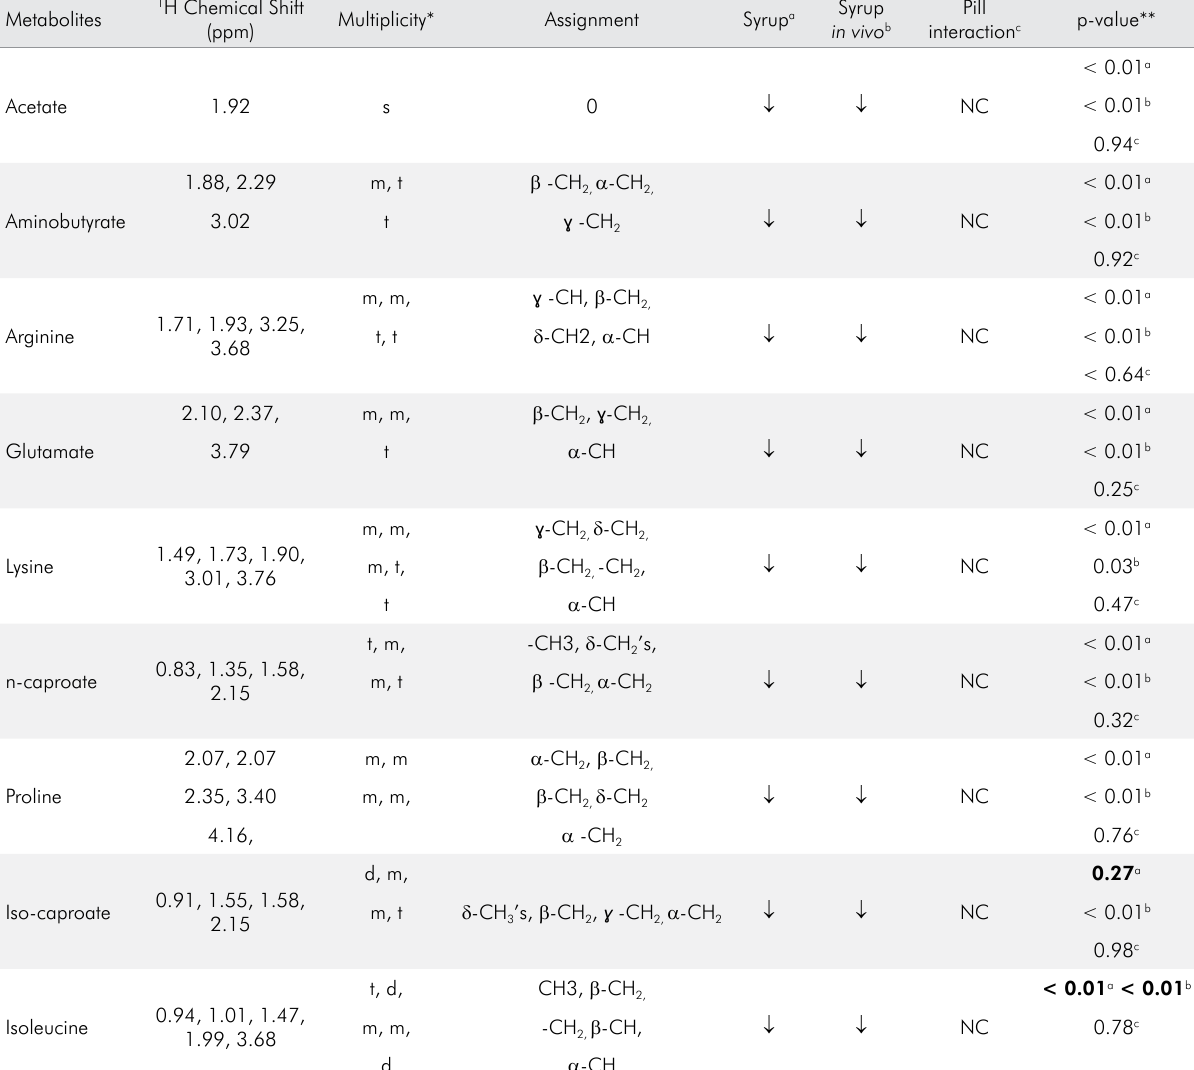
Table. Resonance assignments of salivary metabolite components before and after application of antihistamine mixture.